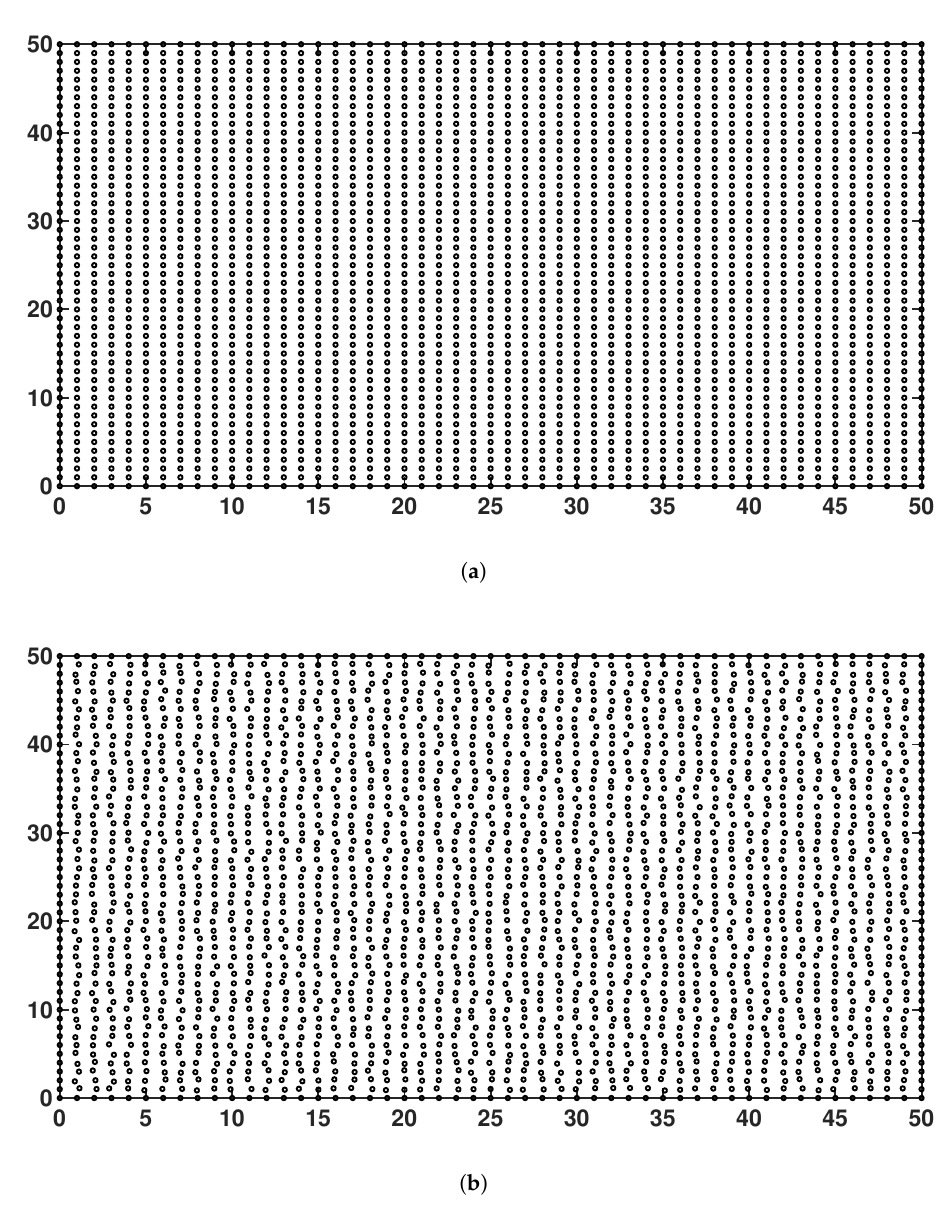
Figure 1. Nodal arrangement for the propagation of planar acoustic waves in LRPIC-LBM simulations: ( a ) Regular nodes. ( b ) Irregular